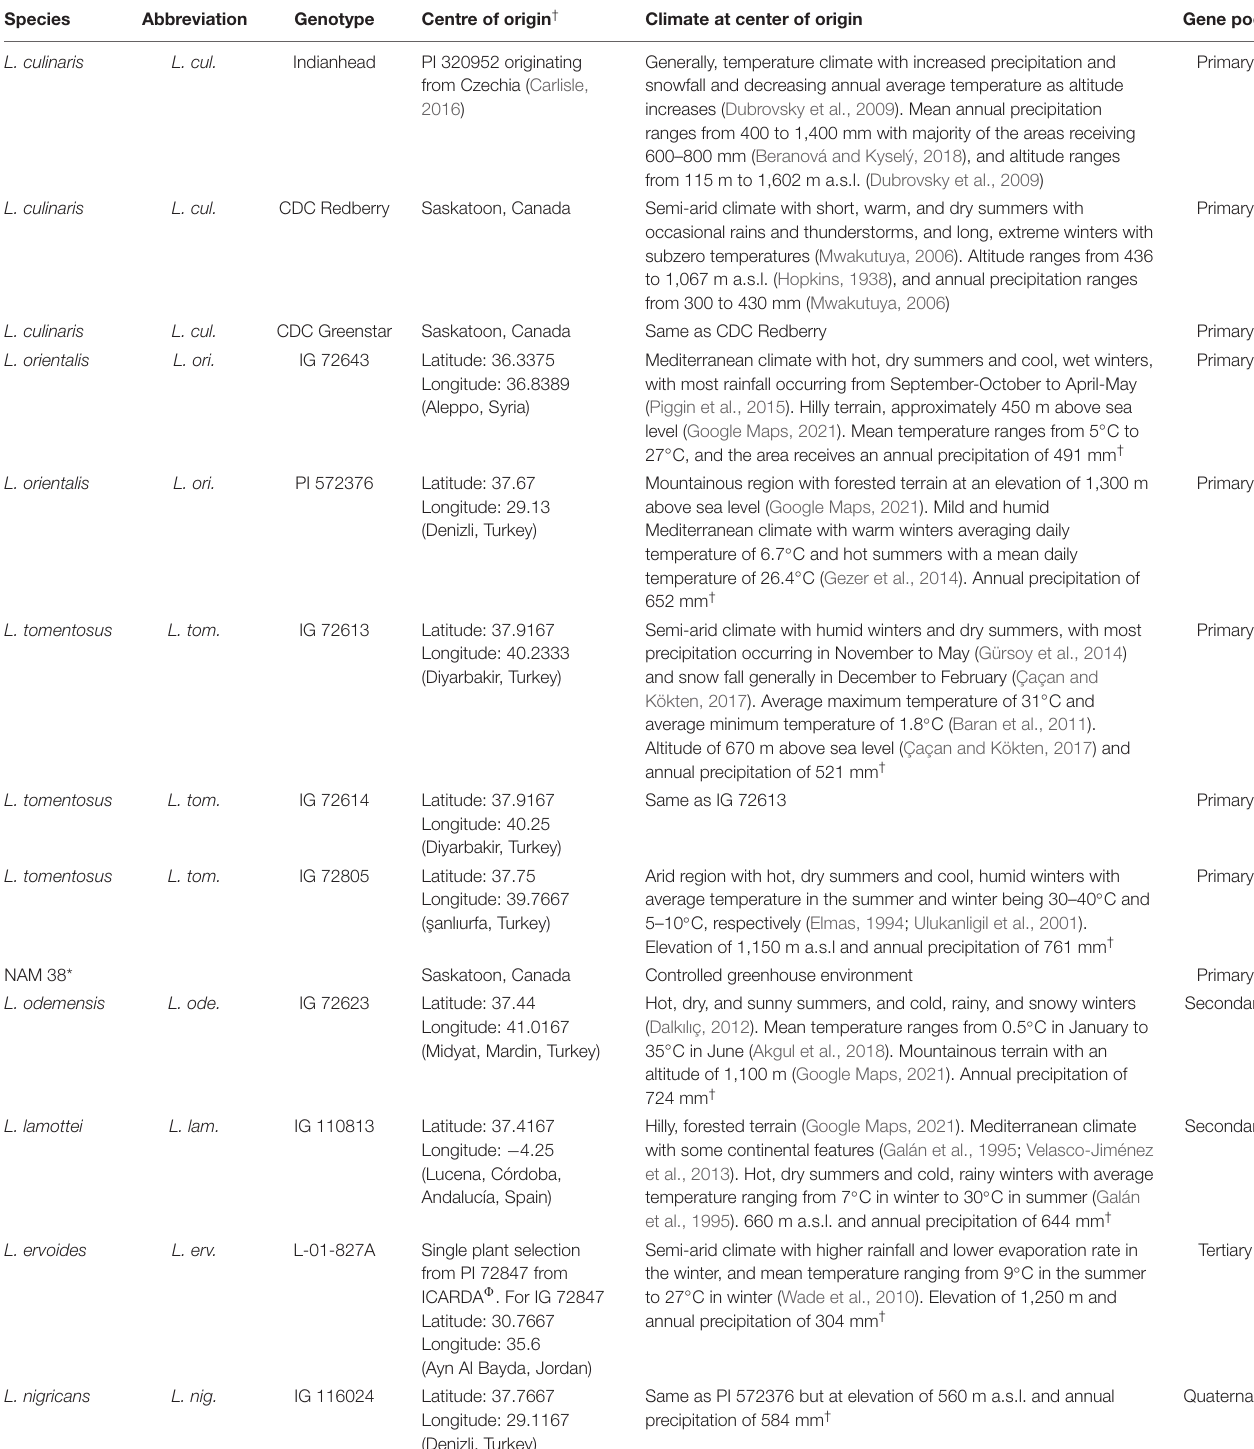
Gene pool classification is based on Wong et al. (2015). † Plant genetic resources accession-level data provided by: International Center for Agricultural Research in the Dry Areas (ICARDA), http://www.icarda.org/, Lebanon and Morocco; and USDA National Plant Germplasm System, https://npgsweb.ars-grin.gov, United States. All intellectual property rights (including copyright) in the data are owned and retained by the said institutions. Data accessed through GENESYS Global Portal on Plant Genetic Resources, http://www.genesys-pgr.org, 2021-23-03. *Nested association mapping population 38. (cid:56) (Fiala et al., 2009).